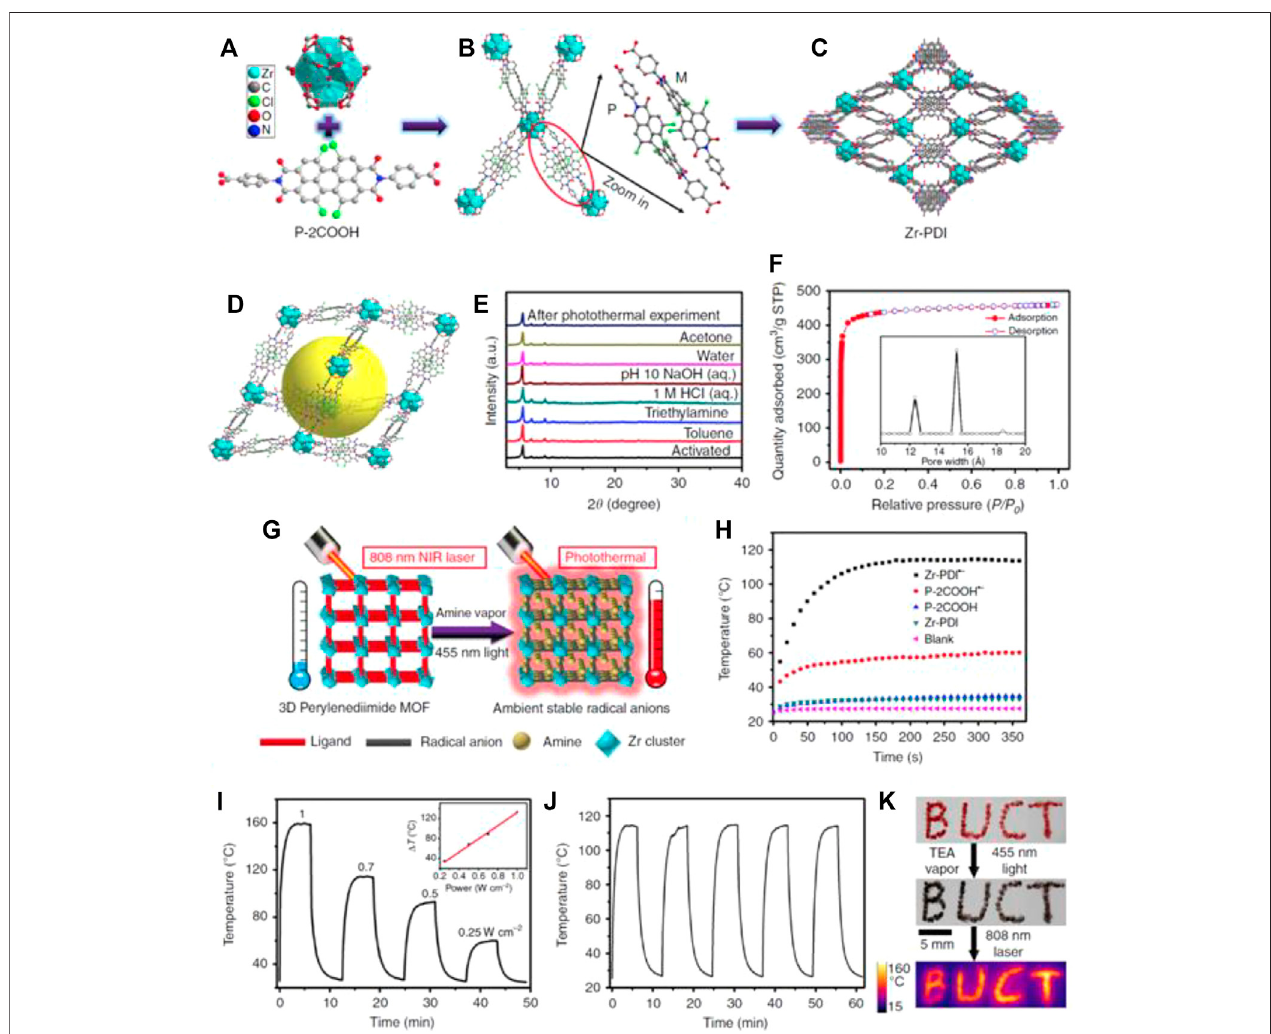
FIGURE 6 | Synthetic schematic diagram of Zr-PDI. (A) Schematic diagram of the special structure of Zr and P-2COOH. (B) The connection method of Zr and P- 2COOH. (C) a-Axis crystal structure of Zr-PDI. (D) The microstructure of Zr-PDI. (E) Light and heat stability curve of Zr-PDI. (F) Nitrogen adsorption curve of Zr-PD and poresizedistribution. (G) SchematicdiagramofphotothermalconversionofZr-PD. (H) Photothermal conversion curves ofZr-PDI cooling curves of Zr-PD at different optical powers. (J) Light and heat stability curve of Zr-PDI. (K) Photothermal digital picture of Zr-PDI-BUCT. Reproduced with permission (Lü et al., 2019). Copyright 2019, Nature Communication.